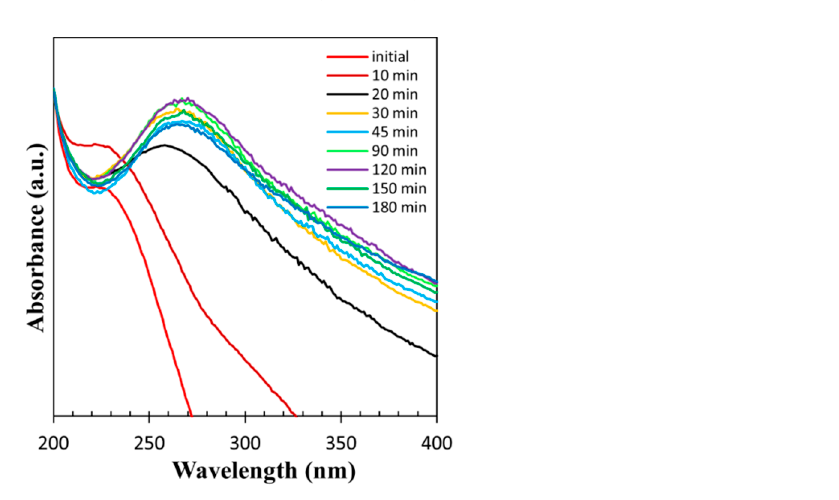
Figure 3. UV-vis spectra of the reaction mixture of the reduction of GO to rGO using lemon juice at different temperatures (conditions: pH = 12.3 and 2 h). The surface functionality of GO and rGO was evaluated by FTIR analysis. Figure 4 shows the FTIR spectra of GO and rGO synthesized using lemon juice at different tem- peratures, clearly reflecting the removal of the oxygen functionalities in GO.